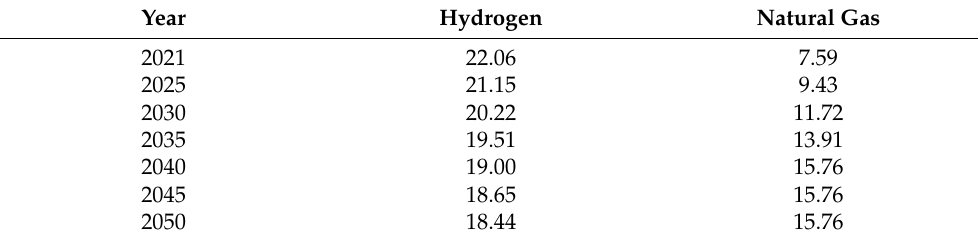
Table A12. Hydrogen and natural gas price forecast